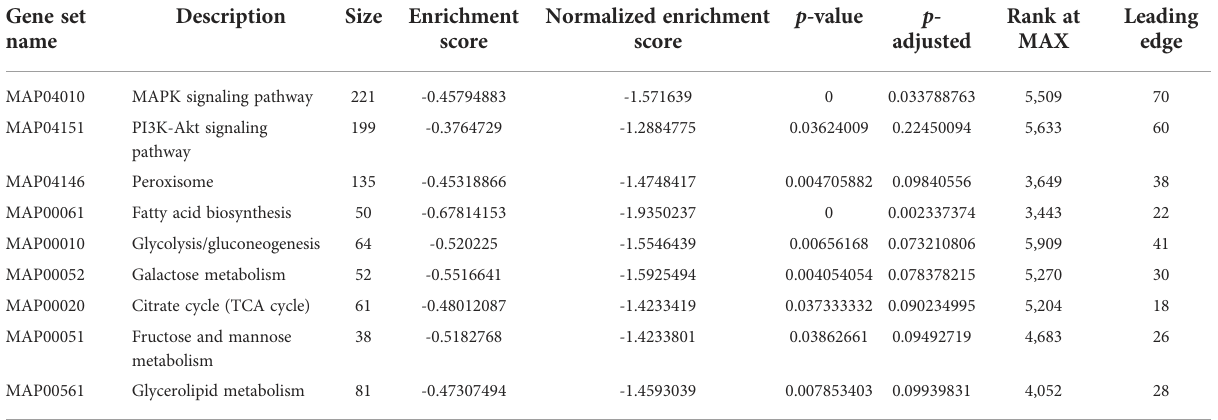
TABLE 1 List of gene set enrichment analysis